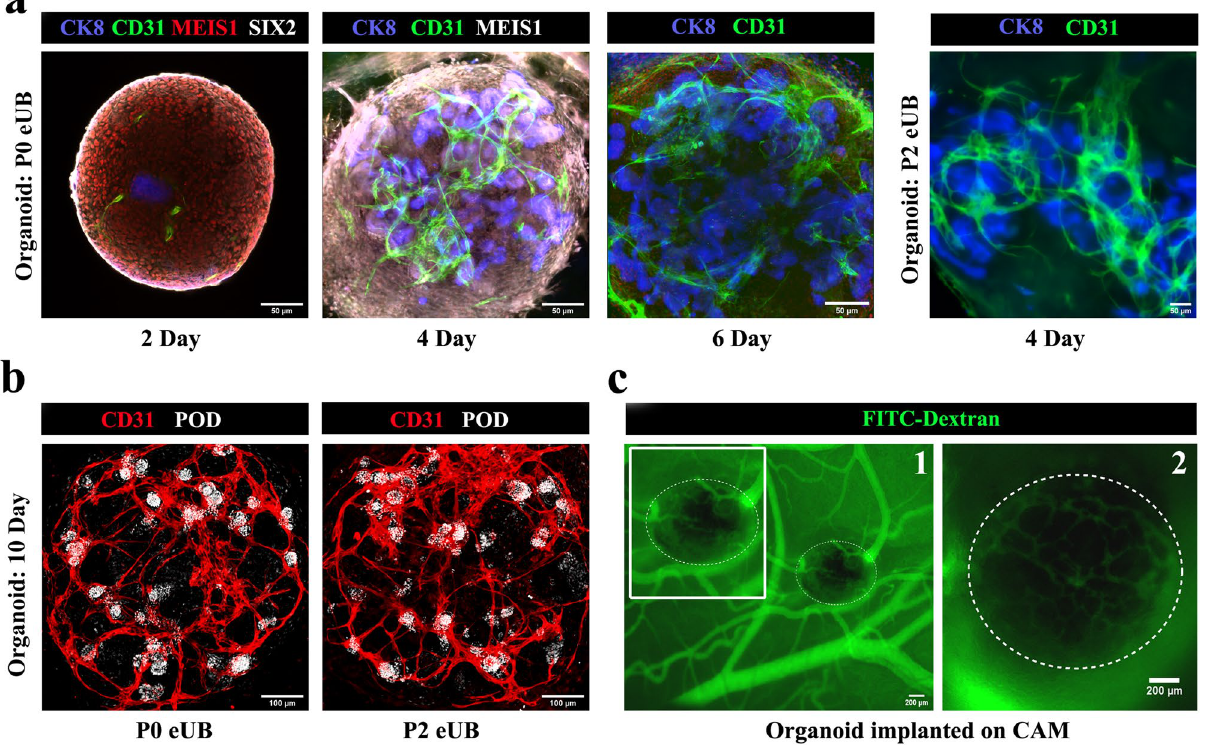
Figure 7. Small blood vessel formation in all-mESC organoid. ( a ) Blood vessel formation and its growth around ureteric bud branches in all-mESC organoids. n = 3/3. Scale bar, 50 µm ( b ) Immunostaining shows that vessels extend to the podocytes (white) at the proximal end of nephrons by day 10. Organoids generated using eUBs from differentiated embryoid bodies (Organoid: P0 eUB) and passage 2 eUB (Organoid: P2 eUB) were used for experiments. n = 4/4. Scale bar, 100 µm. ( c ) Fluorescence image of CAM implanted organoid after FITC dextran injection. (1) low and (2) high magnification images are shown. The organoid is marked with doted lines. Inset image shows the zoomed view of the organoid. n = 3/5. Scale bar, 200 µm. POD: podocalyxin (podocyte marker), JAG: jagged1 (proximal tubule marker), NKCC2: Na–K-Cl cotransporter 2 (distal tubular marker), ECAD: E cadherin (collecting duct / distal tubular marker), CD31: platelet endothelial cell adhesion molecule (endothelial cells marker), CK8: cytokeratin 8 (collecting duct marker), MEIS1: Meis homeobox 1 (stromal marker), SIX2: Six homeobox 2 (nephron progenitor